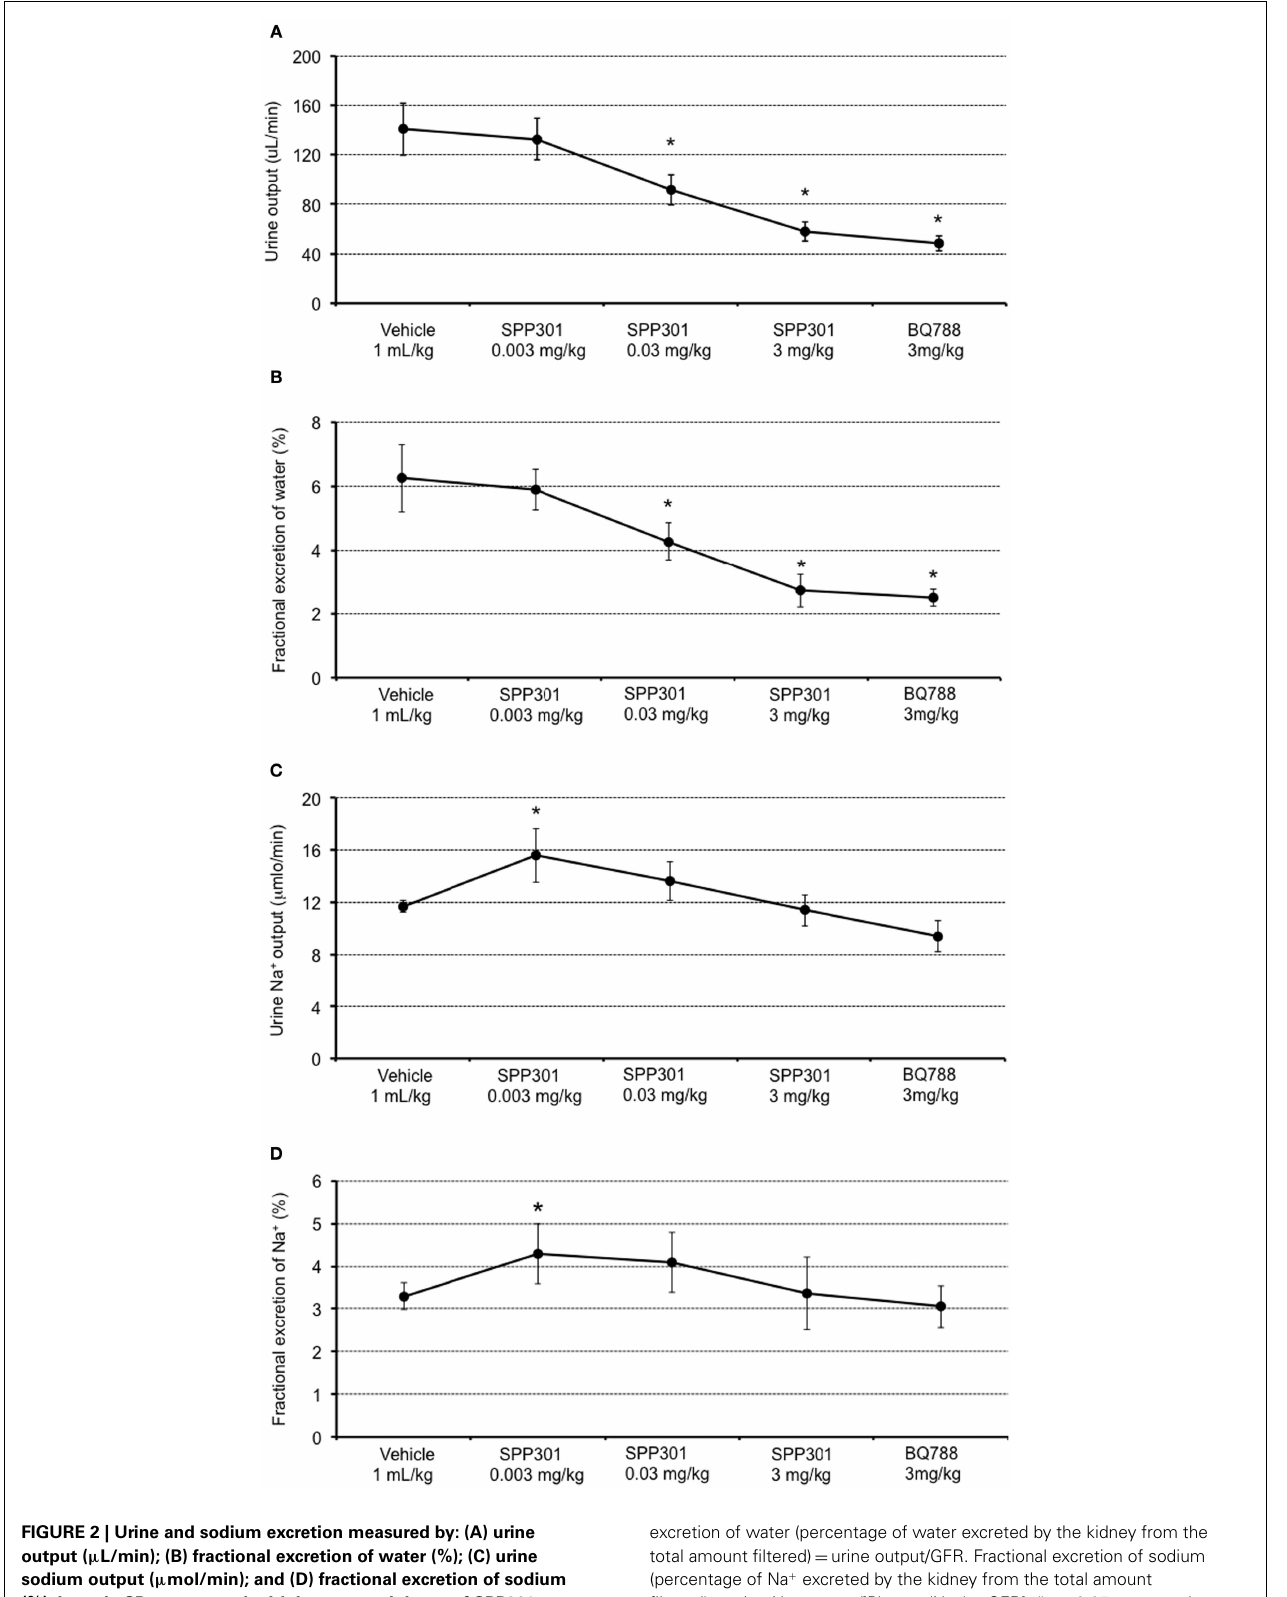
FIGURE 2 | Urine and sodium excretion measured by: (A) urine output ( μ L/min); (B) fractional excretion of water (%); (C) urine sodium output ( μ mol/min); and (D) fractional excretion of sodium (%); in male SD rats treated with incremental doses of SPP301 (0.003; 0.03; 3mg/kg) followed by BQ-788 (3mg/kg). Fractional